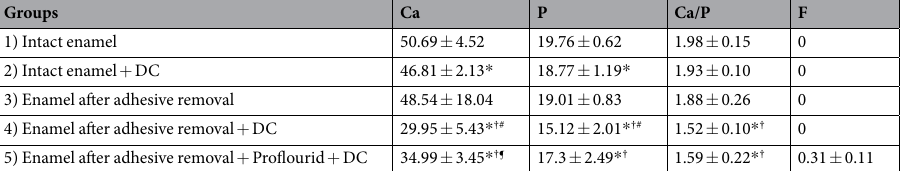
Table 2. Weight percentage (mean ± standard deviation) of calcium (Ca), phosphorous (P) and Fluor (F). Ratio Ca/P (mol/mol). DC: demineralization cycles. The Mann-Whitney test applying Bonferroni correction (p < 0.005) found significant differences between groups: * vs Intact enamel. † vs Intact enamel + DC. # vs Enamel after adhesive removal. ¶ vs Enamel after adhesive removal +